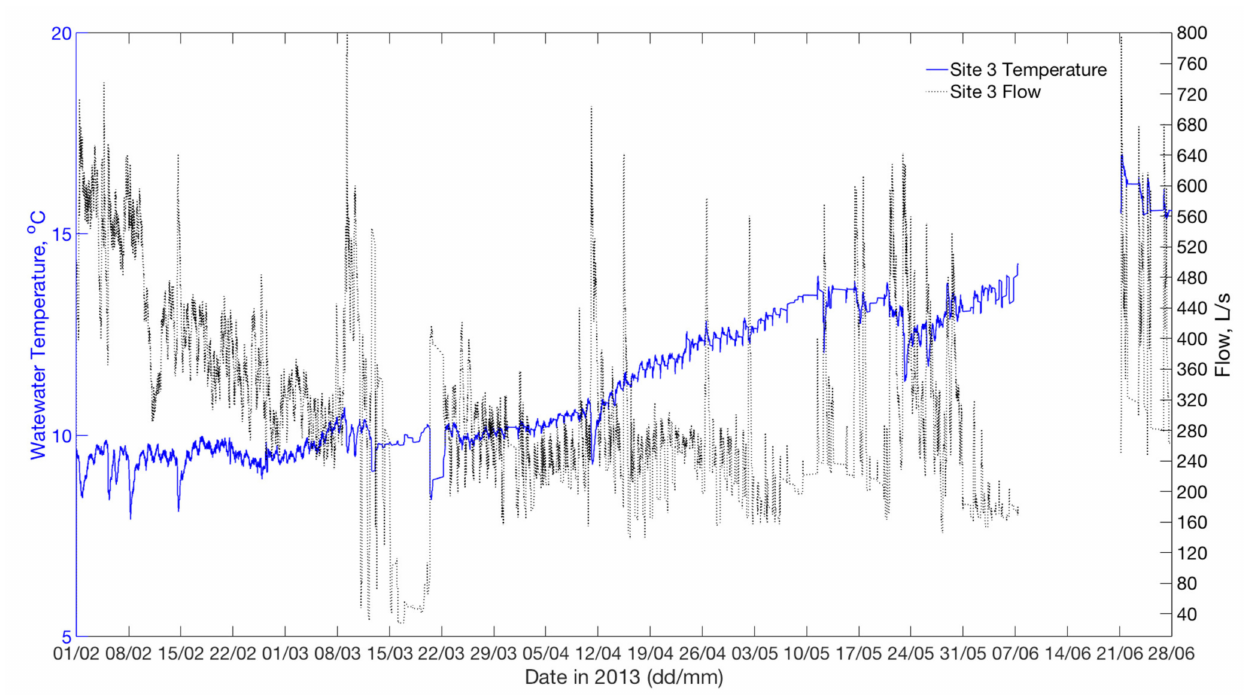
Figure 4. Observed wastewater temperatures and flow rates for site 3 (used for validating the collector sewer model).